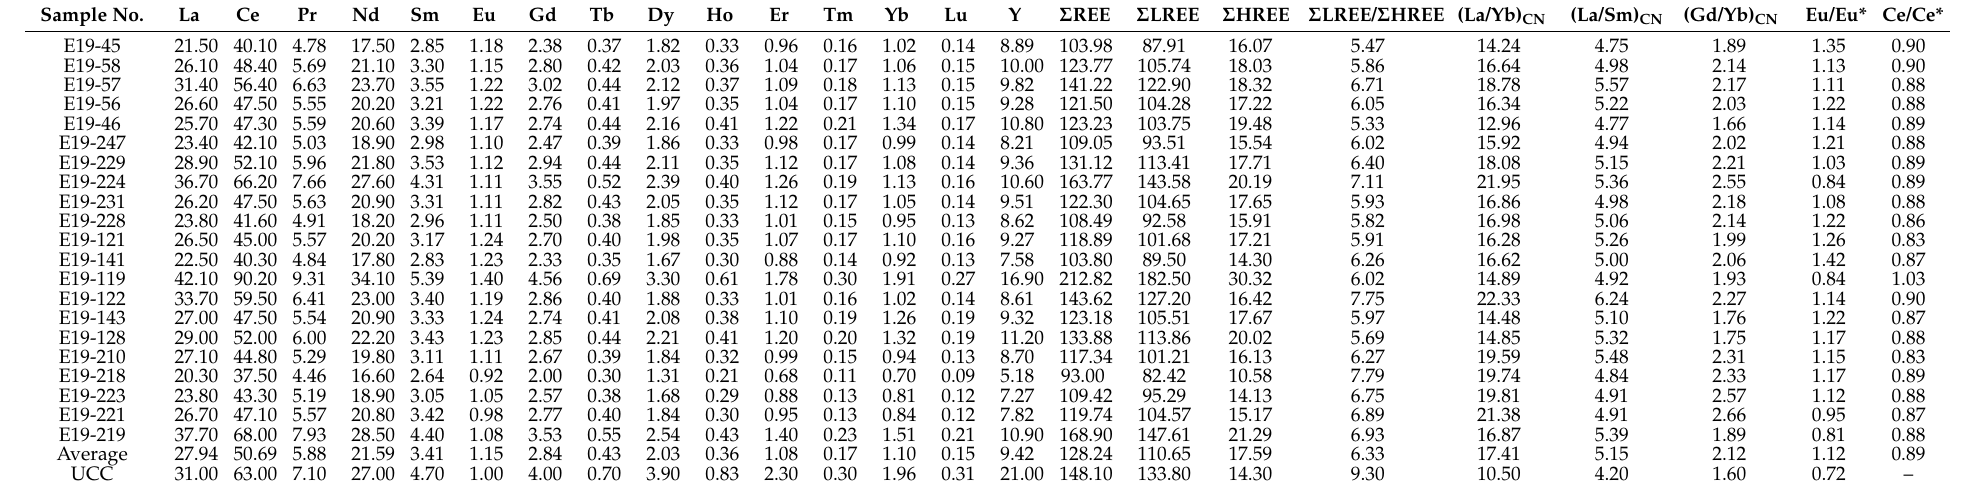
Table 3. Rare earth element concentrations of sandstones from the Zhiluo